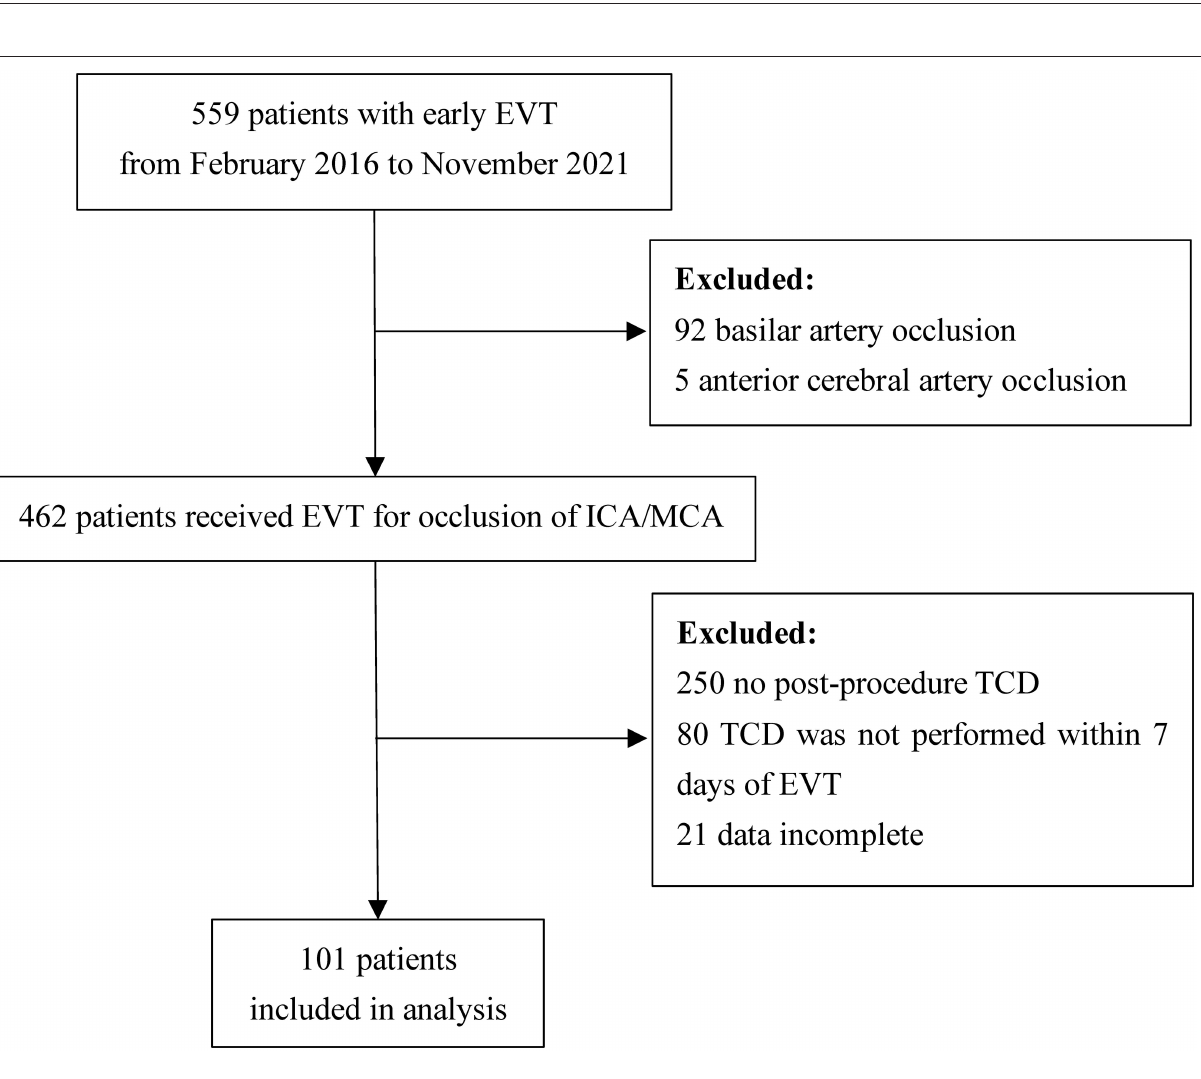
Frontiers in Neurology | www.frontiersin.org